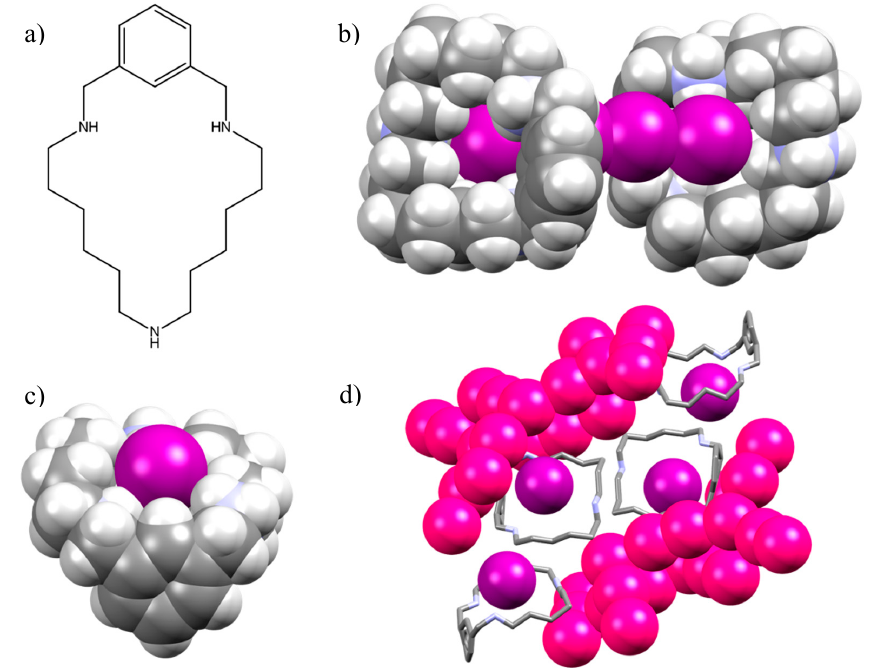
Figure 1. Summary of the crystallographic results presented in [21] as functional to the current discussion. Color code: white, H; grey, C; cyan, N; violet, I; I 82 − networks highlighted in pink. ( a ) Structure of the large azacyclophane triazabicyclo[17.3.1]tricosa-1(23),19,21-triene employed as a ligand. Evidence of ligand-iodide size/shape complementarity: ( b ) as found in the I 42 − complex (CSD refcode NABWOD [21]) and ( c ) in the mixed iodide–I 82 − complex (CSD refcode NABWUJ [21]); ( d ) I 82 − network (in pink) (CSD refcode NABWUJ [21]) mainly developing around the external hydrophobic rim of the cyclophane.